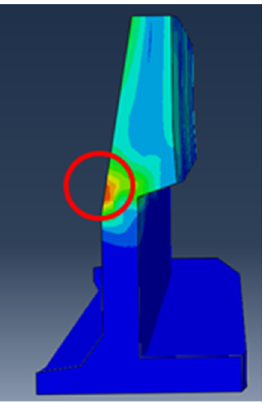
Figure 8. Stress concentration at release rail neck.